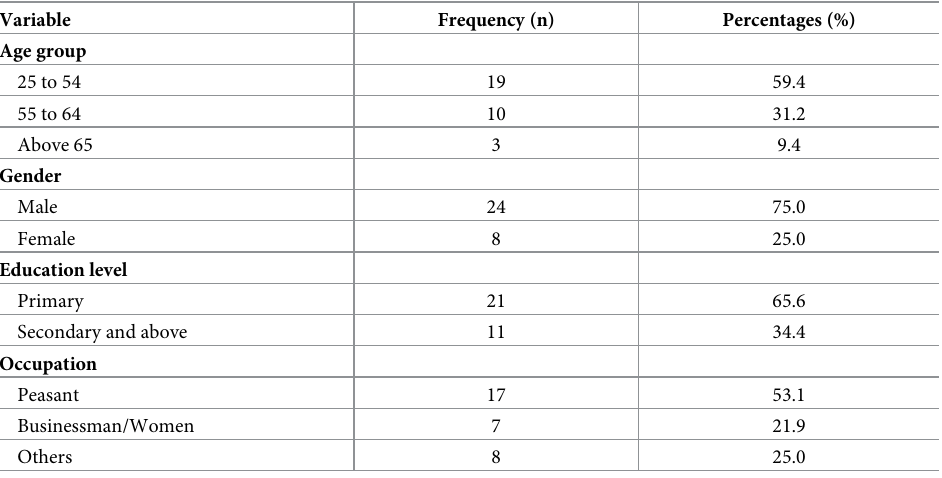
Table 1. Socio-demographic characteristics of key informants (n =